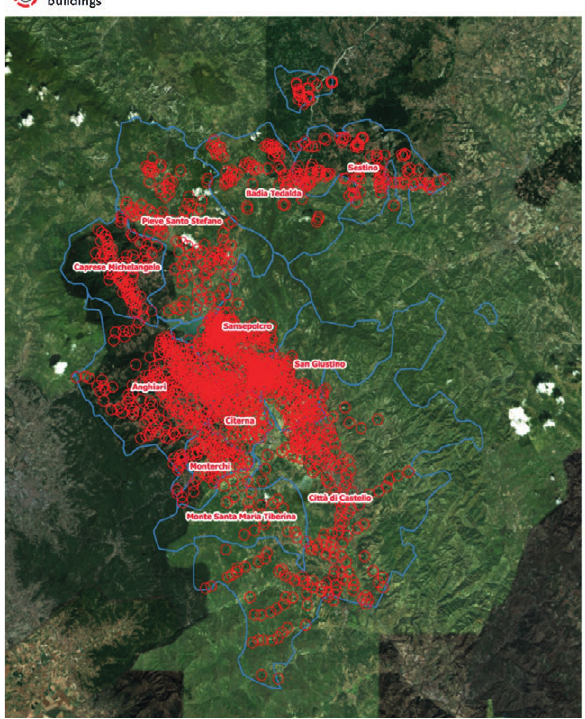
Figure A2.1. Urbanization of rural areas in Tiber